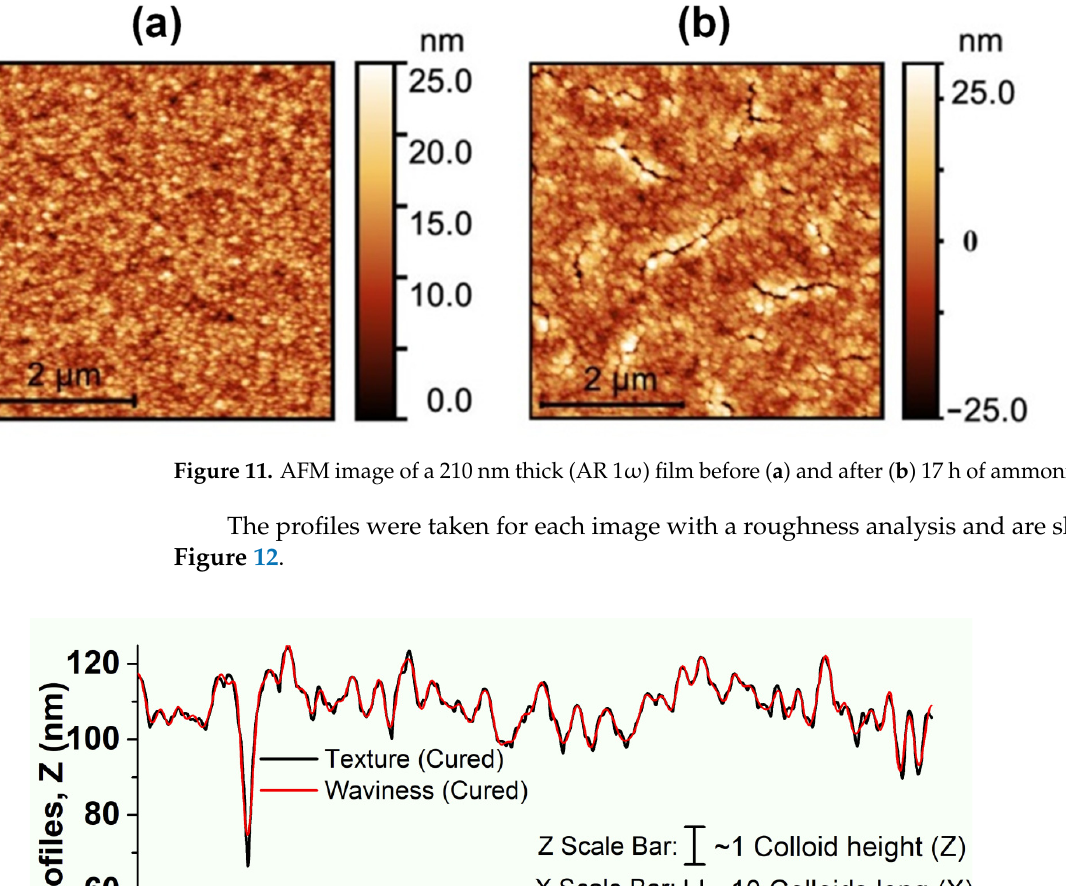
Figure 10. Example of crazing after ammonia curing seen through a dark field microscope ( a ) and measured by AFM ( b ).